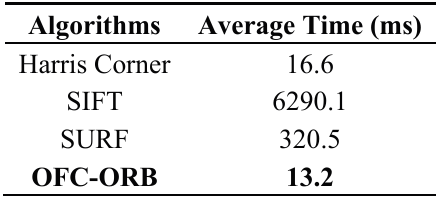
Table 1. Performance comparisons of various